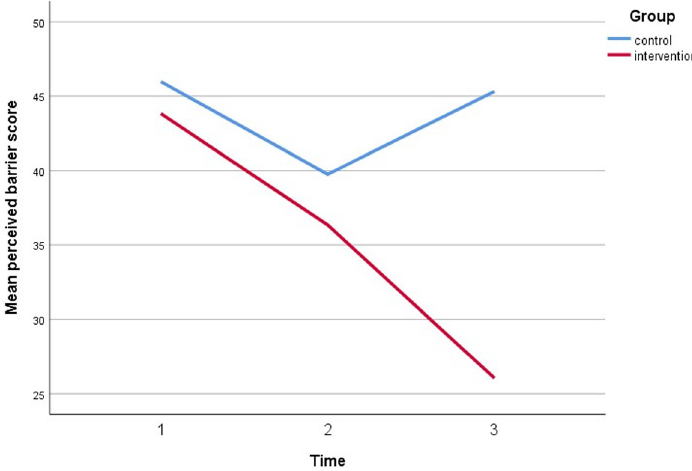
Fig 8. A plot of perceived barrier scores among respondents, showing an interaction between groups and time.